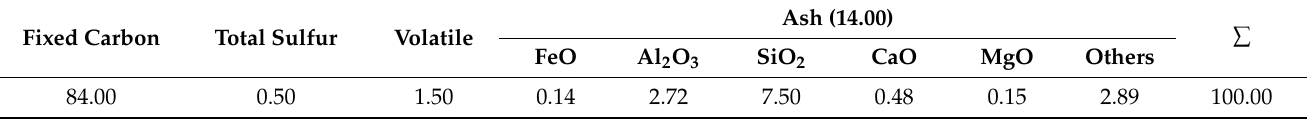
Table 2. Proximate analysis of the coke breeze and the ash composition (wt, %)